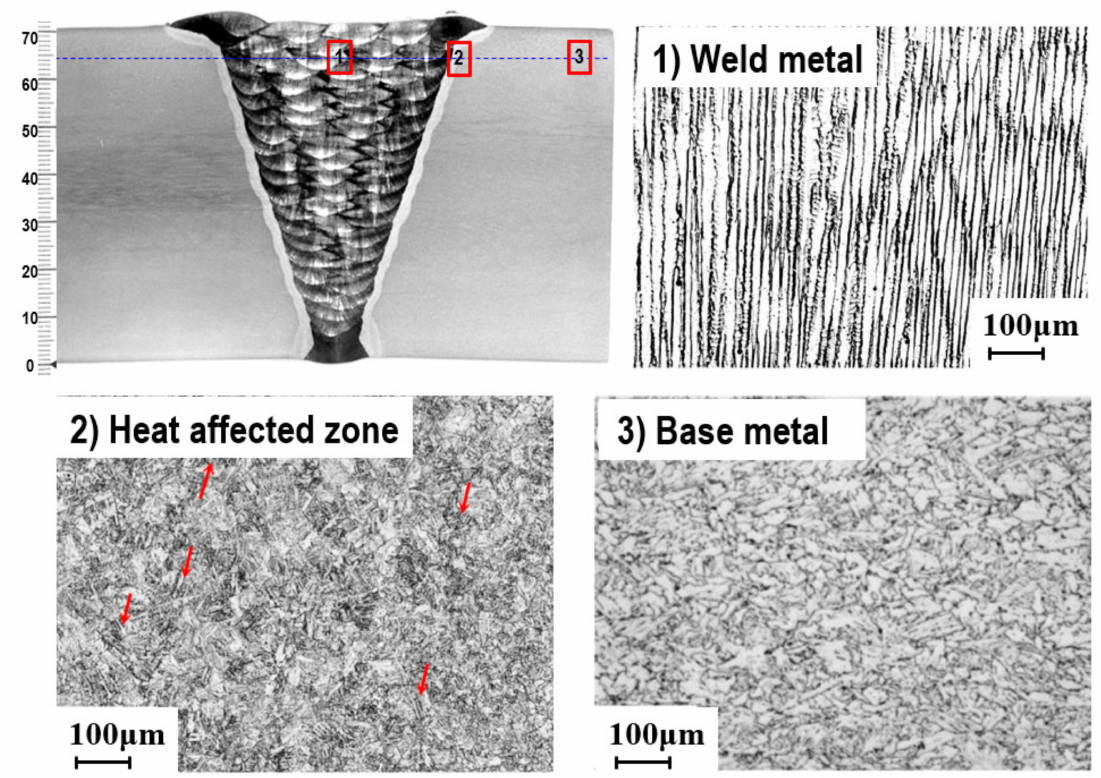
Figure 10. Cross-sectional macrostructure of the low transformation temperature combined with a high heat input weld specimen.